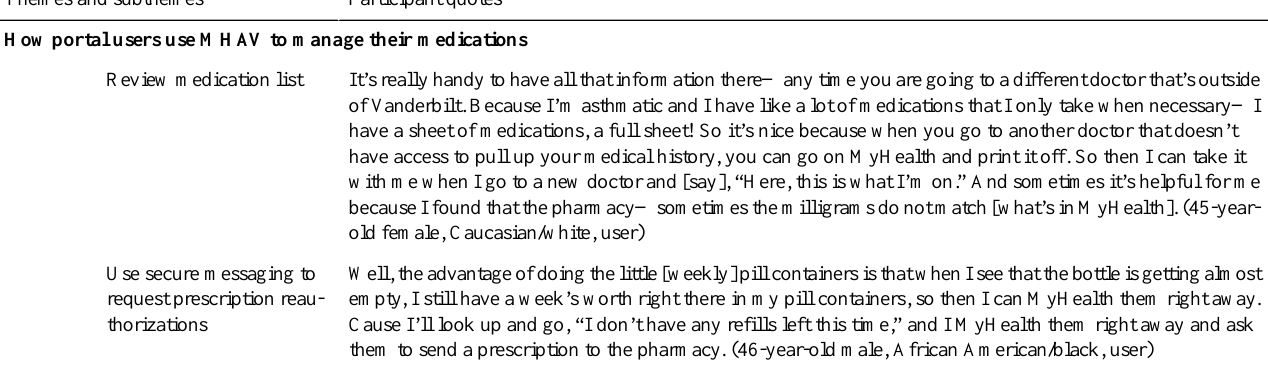
Table 2. Participant comments about MyHealthAtVanderbilt (MHAV) and medication management. Participant quotesThemes and